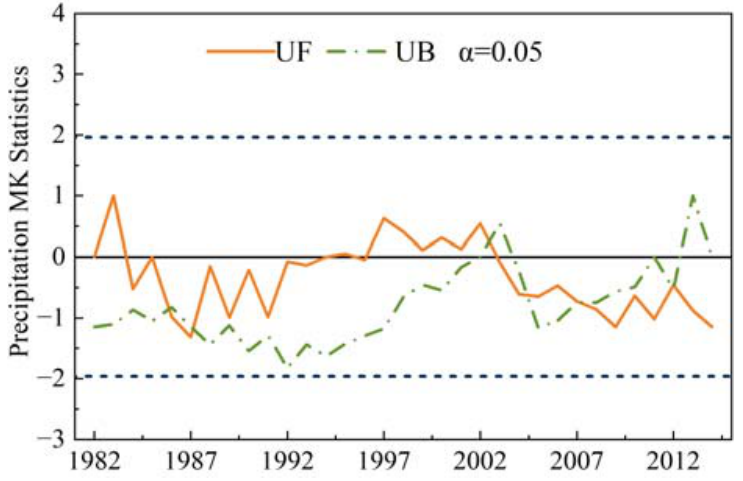
intersection of the forward statistic sequence (UF) and backward static sequence (UB) for the MK analysis (Figure 6) showed that an abrupt decrease occurred after 2003 in the annual precipitation.